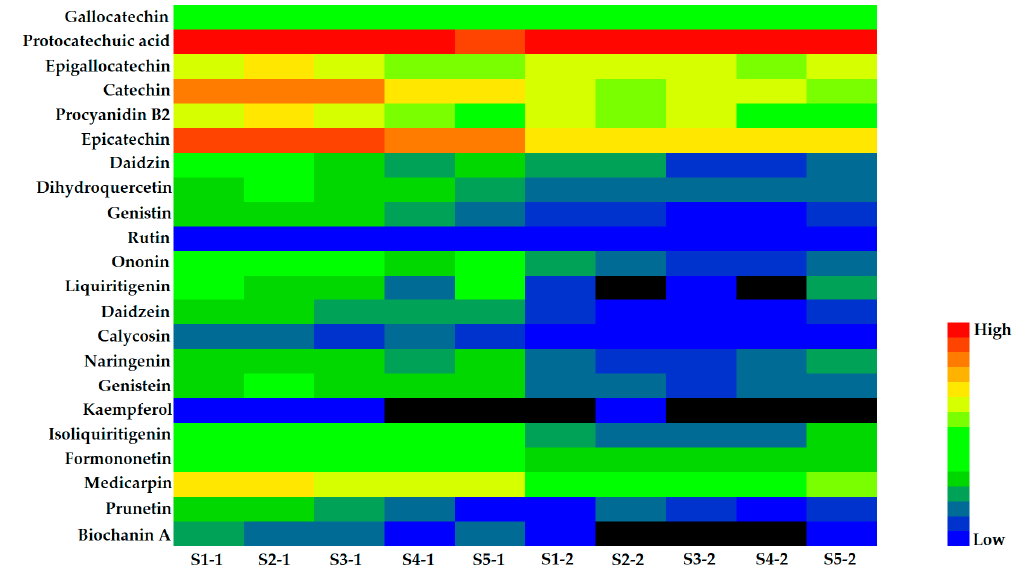
Figure 2. The content difference of 22 compounds by heat map.